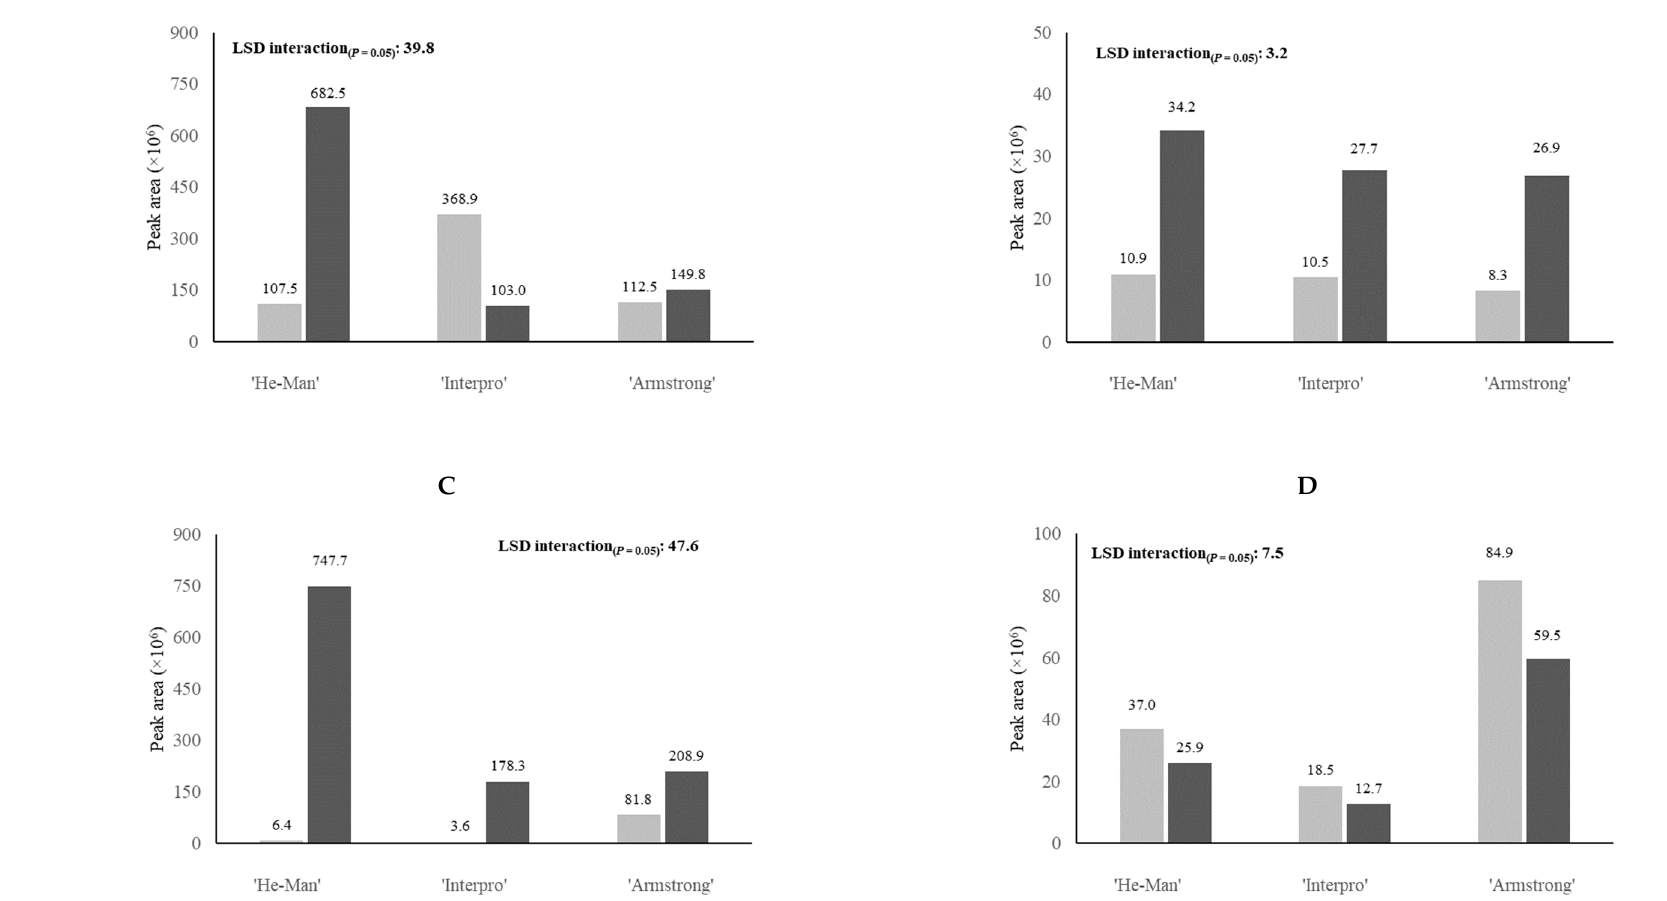
Figure 3. Peak area ( × 10 6 ) of octanal ( A ), β -ionone ( B ), 6-methyl-5-hepten-2-one ( C ), and methyl salicylate ( D ) in tomatoes “Sir Elyan” as a ff ected by ‘rootstock × ripening stage’ interaction. Light bars: S 1 . Dark bars: S 2 .